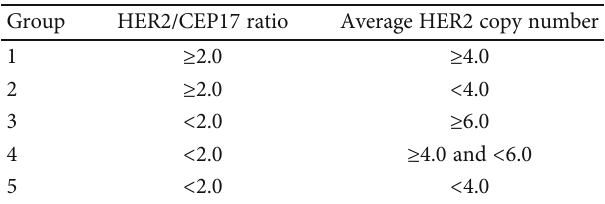
Table 1: ASCO/CAP guidelines categorize HER2 FISH results into 5 groups based on HER2/CEP17 ratio and average HER2 copy